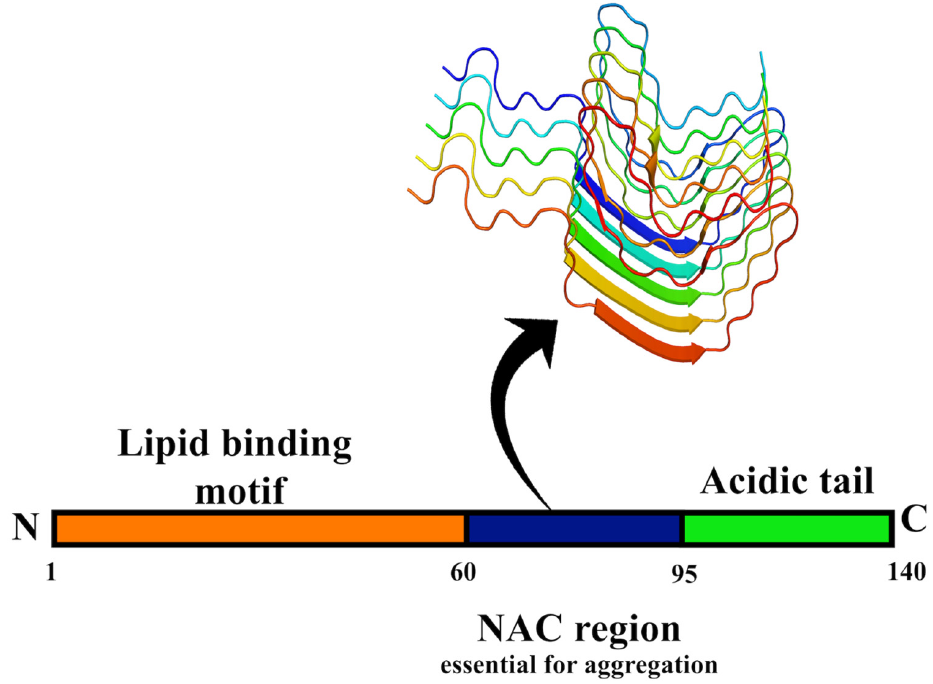
Figure 4. Domain structure of the α -syn protein. The lipid-binding N-terminal domain (NTD) is represented in orange, while the non-A β component (NAC) region necessary for the aggregation of α -syn protein is in blue. The C-terminal domain (CTD) of α -syn protein is represented in green. On top, the arrangement of α -syn protein in fibrillar form is shown (PDB ID: 6FLT) [27].